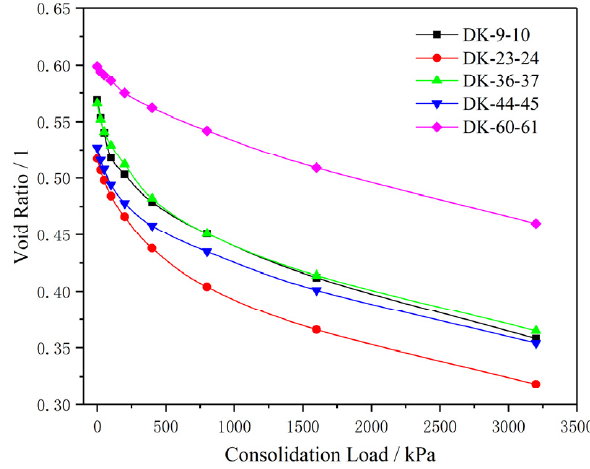
Figure 2. The e–p consolidation compression curves of the samples.